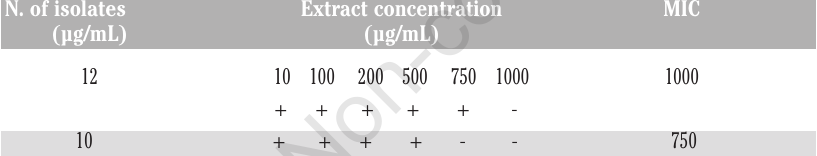
Table 2. Minimum inhibitory concentration of S .persica extract against H. pylori strains isolated from the Gastroenterology Division of the Afzalipoor Hospital in Kerman, Iran. N. of isolates